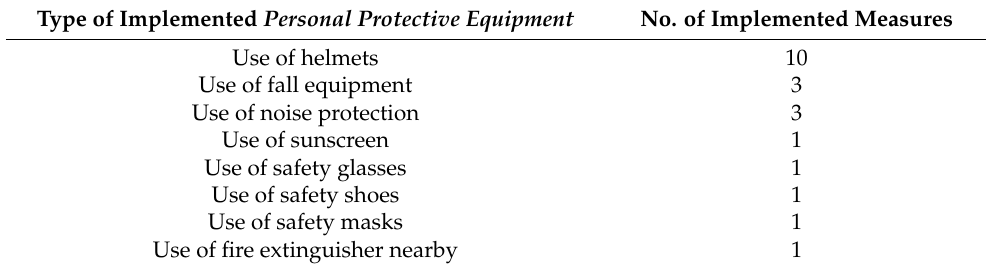
Table 4. Subcategories of successfully implemented personal protective equipment